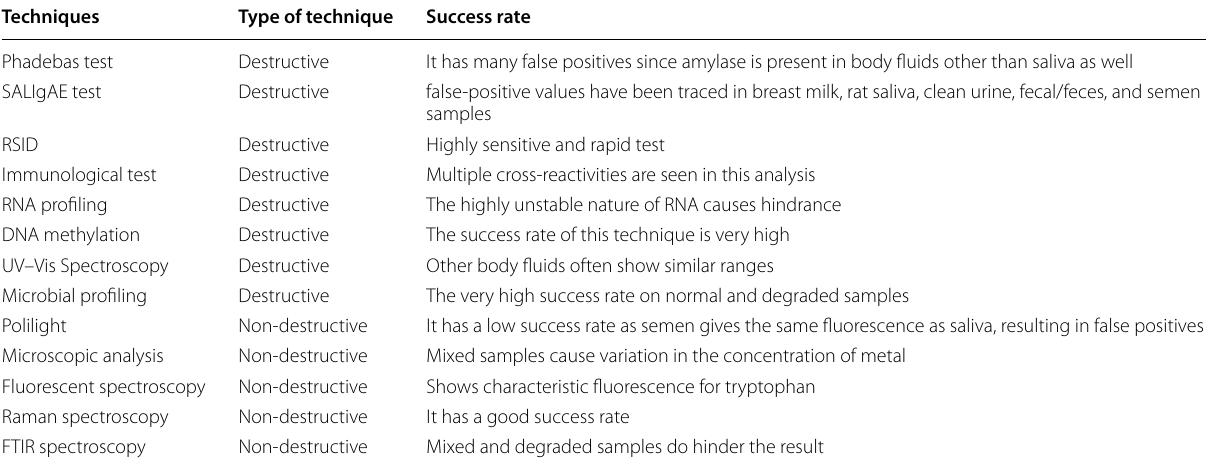
Table 5 List of destructive techniques used in saliva analysis